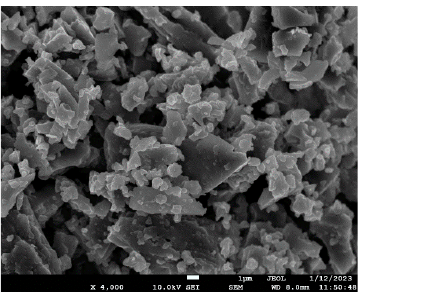
Figure 1. SEM micrographs of prepared BC after miscanthus pyrolysis at 700 °C and grinding in low ( left ) and high ( right ) magnification.